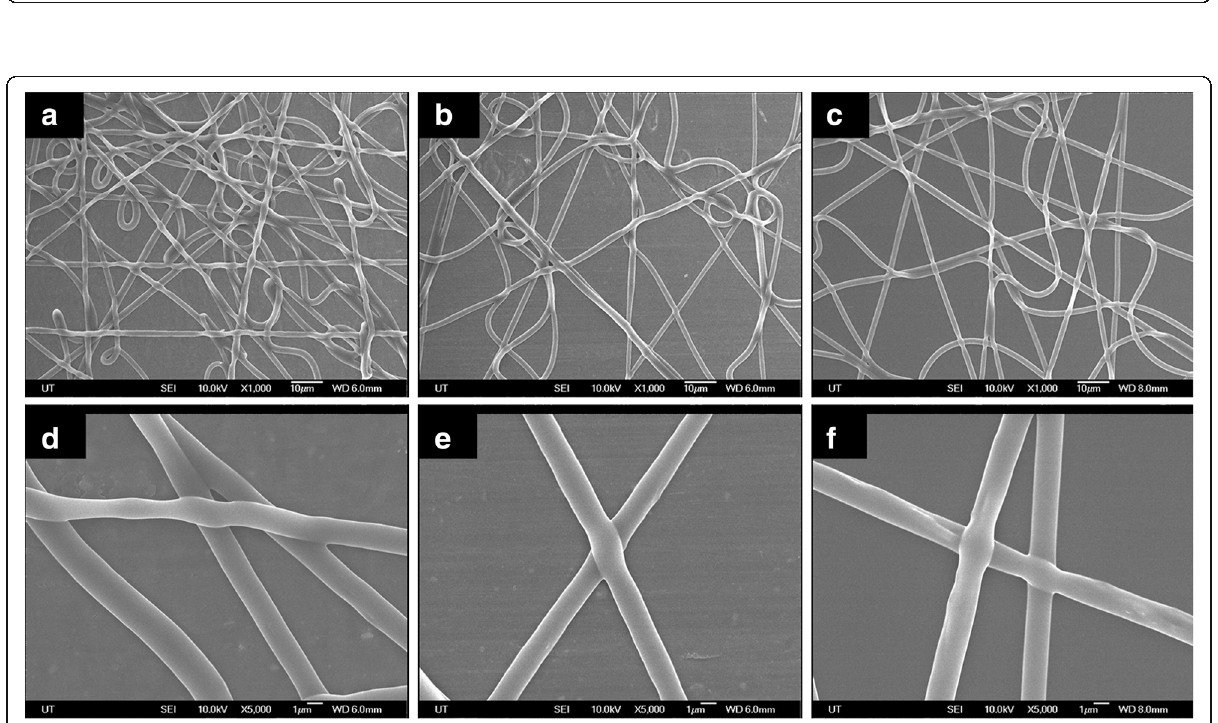
Fig. 3 Images of electrospun fiber on polymer substrate with hydrophilic (right) and hydrophobic (left) surface. a PCL. b PS. c Cellulose acetate. d PVDF (scale bar: 10 mm)